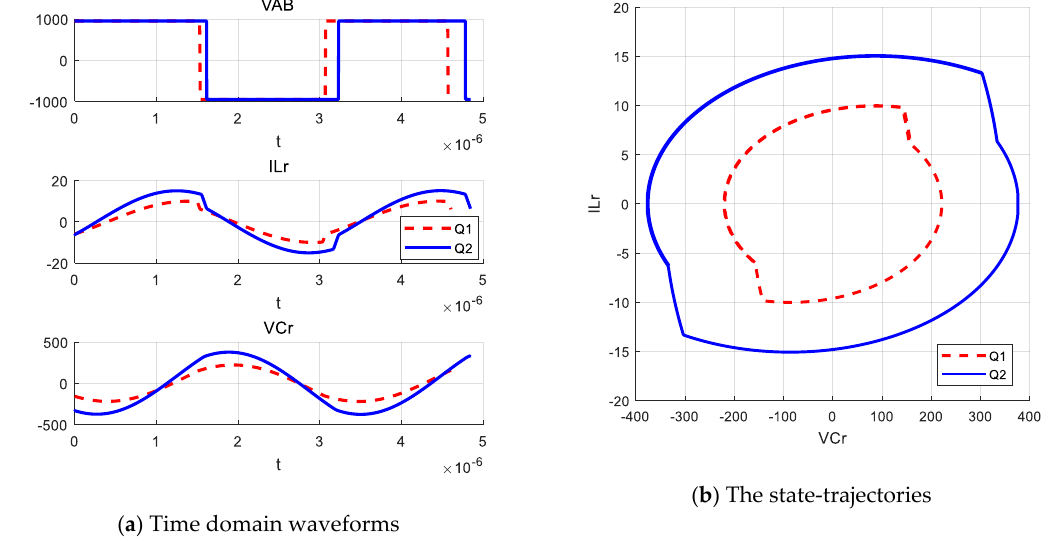
Figure 10. MATLAB calculation results above resonant frequency.